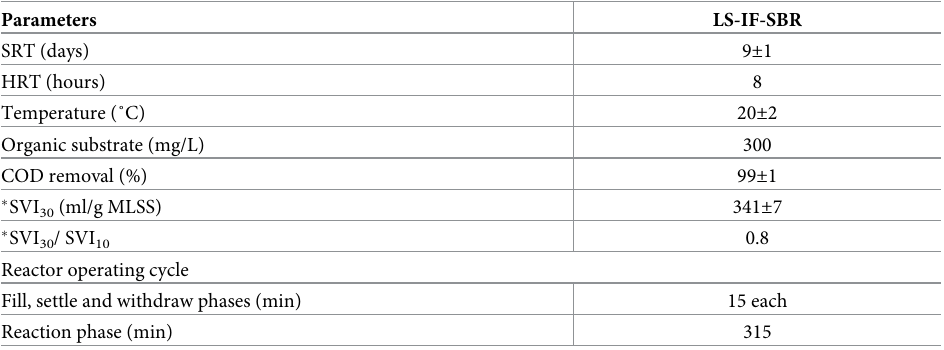
Table 1. LS IF-SBR operating conditions and